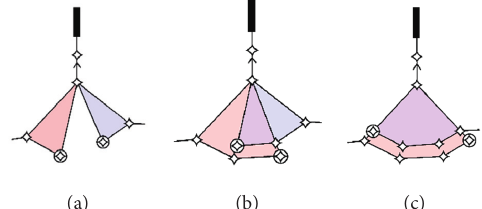
Figure 3: Three layout options of sequencing legs. (a) Parallel legs with full overlap. (b) Parallel legs with partial overlap. (c) Parallel legs with no overlap.